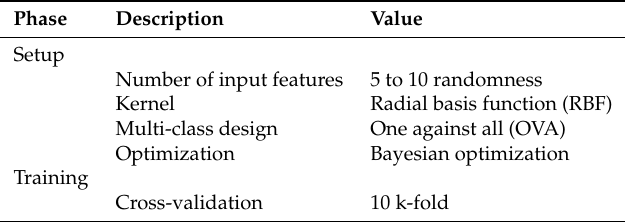
Table 11. SVM-RBF